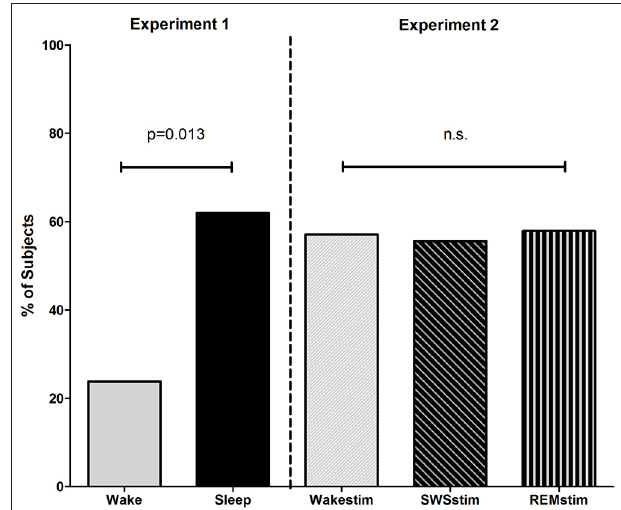
FIGURE 2 | Sleep facilitates problem solving. Experiment 1 , percentage of subjects who solved the problem after the sleep and wake incubation interval. Experiment 2 , percentage of subjects who solved the problem after the incubation interval with targeted memory reactivation during wakefulness (Wakestim), SWS (SWSstim) and REM sleep